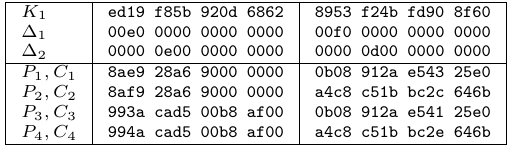
Table 10: One of the quartets of the 15-round boomerang distinguisher of